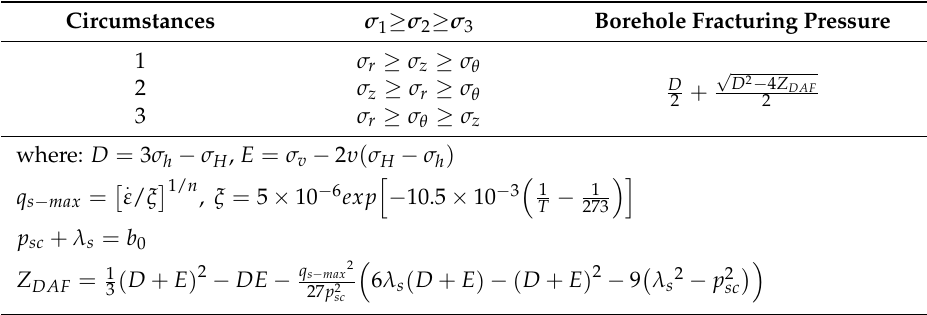
Table 6. Derradji-Aouat criterion for the determination of the collapse pressure in an ice borehole. Circumstances σ 1 ≥ σ 2 ≥ σ 3 Borehole Collapse Pressure 1 σ θ ≥ σ z ≥ σ r σ θ ≥ σ r ≥ σ z 3 σ z ≥ σ θ ≥ σ r where: A = 3 σ H − σ h , B = σ v + 2 υ ( σ H − σ h ) (cid:104) (cid:16) (cid:2) . (cid:3) 1/ n 1 − 10.5 × 10 − 3 − 1 q s − max = ε / ξ , ξ = 5 × 10 − 6 exp T 273